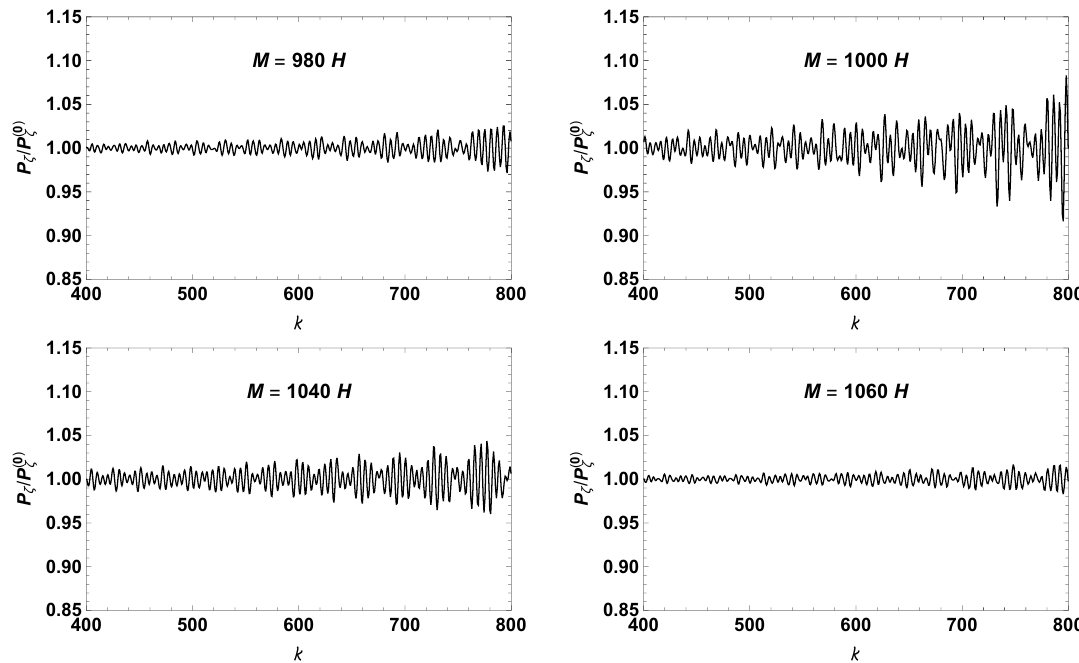
Figure 8 . Like (cid:12)gure 4, this shows the ratio P (cid:16) =P (0) in the high- k range from solving the system (cid:16) numerically. However, now we show the result for a few di(cid:11)erent choices of M (keeping the axes (cid:12)xed in each plot): the top two plots have smaller values M = 980 H; 1000 H and the lower two plots have larger values M = 1040 H; 1060 H